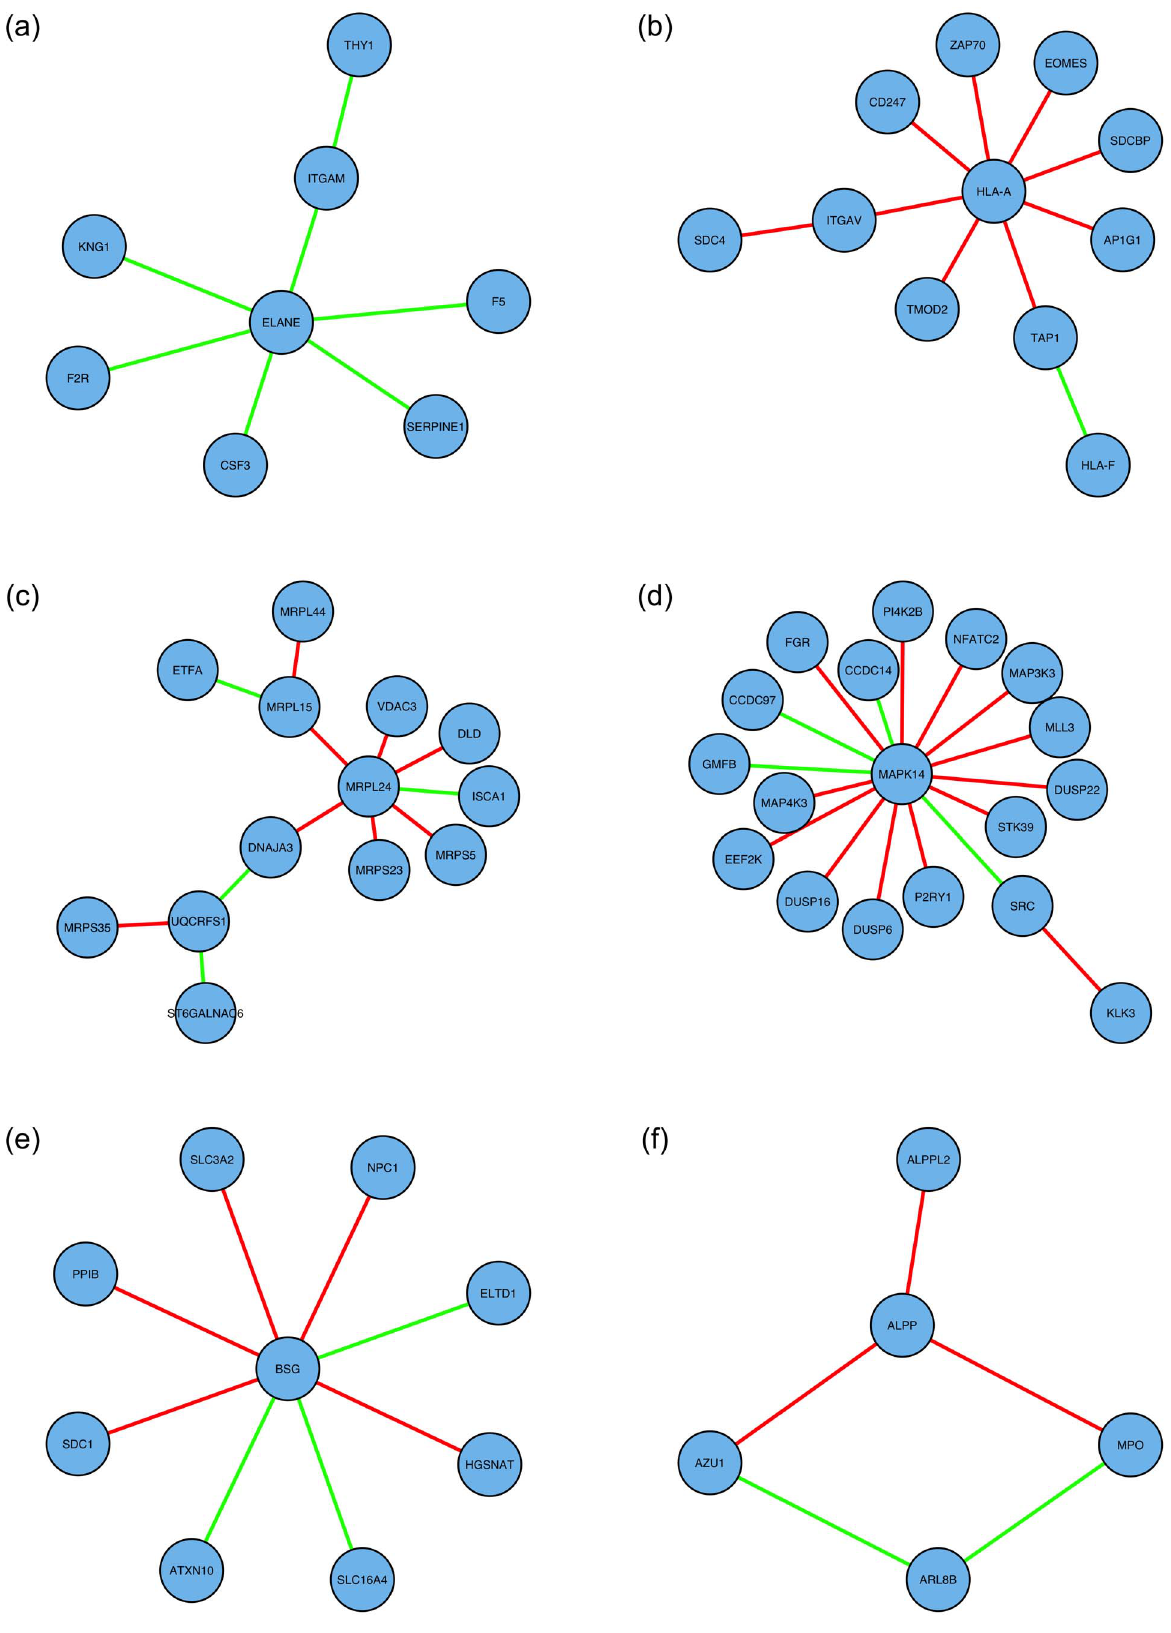
Figure 3. Smaller significant network modules: network diagrams. Network edges displayed in green and red indicate positive and negative hazard ratios, respectively, for the DNAm network correlation measure corresponding to that interaction; these correspond, respectively, to an